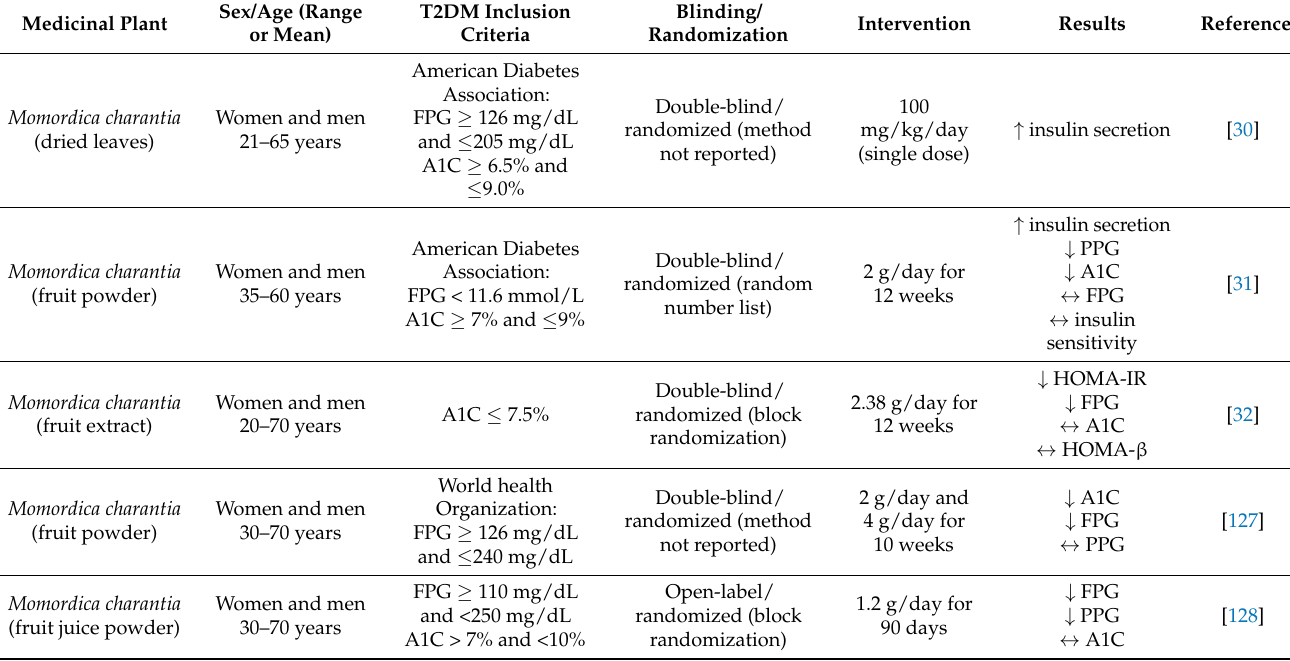
Table 5. Momordica charantia : clinical evidence in type 2 diabetes